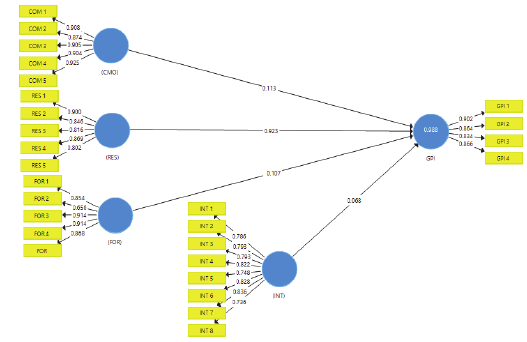
Fig. 1. The Measurement Model